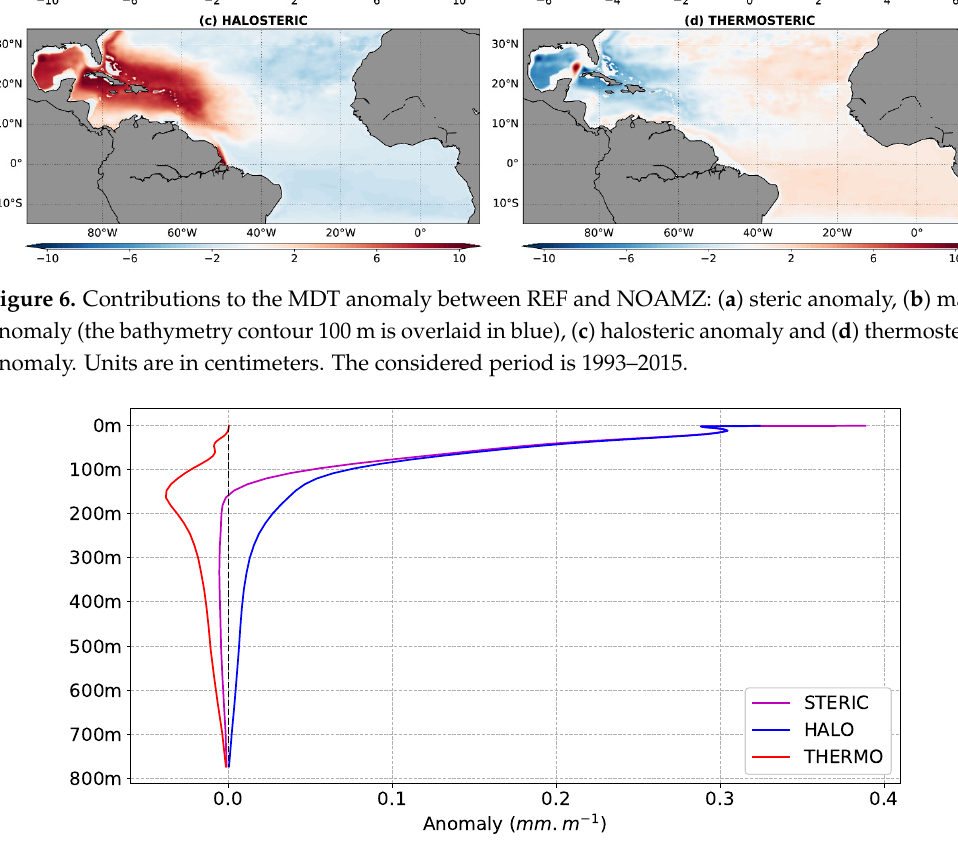
Figure 7. Vertical distribution of steric, halosteric and thermosteric time-mean contributions averaged over the considered area. Units are in millimeters of sea level increase per meter of water column. The considered period is